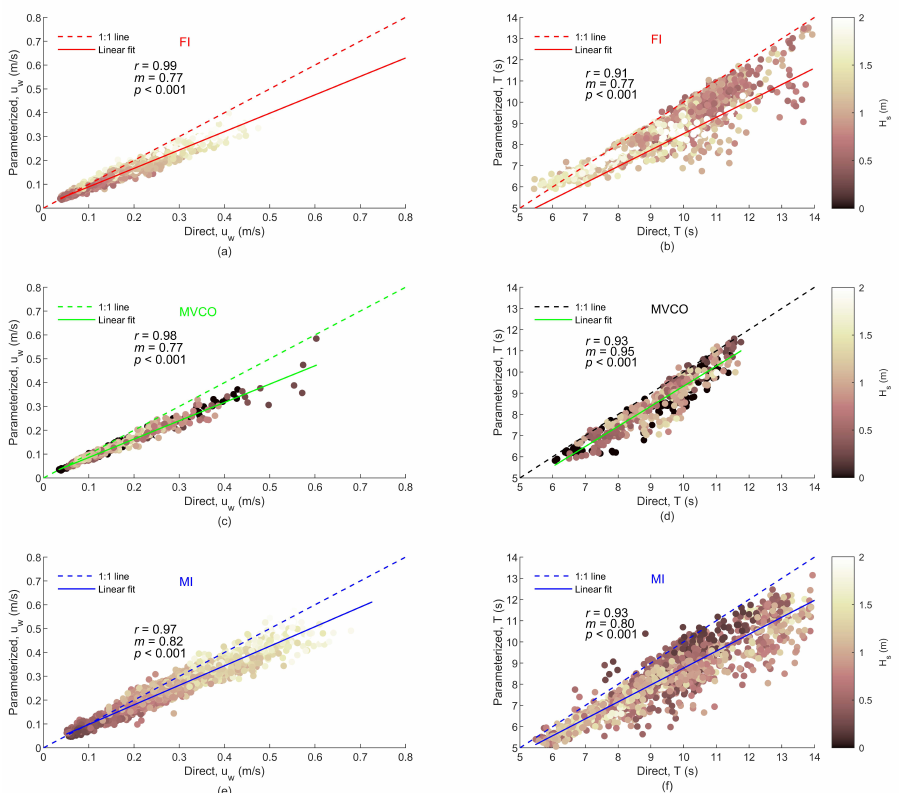
Figure 5. Comparison of representative wave orbital velocity, u w (m/s), and representative wave period, T (s) from ADV based near-bottom (direct) and surface wave spectrum (parameterized) measurements at the Fire Island site ( a , b ), MVCO site ( c , d ), and Matanzas Inlet site ( e , f ), respectively. The color of the circles indicates significant wave height in m. The dashed and solid black lines correspond to an identity line and a linear fit to the points,